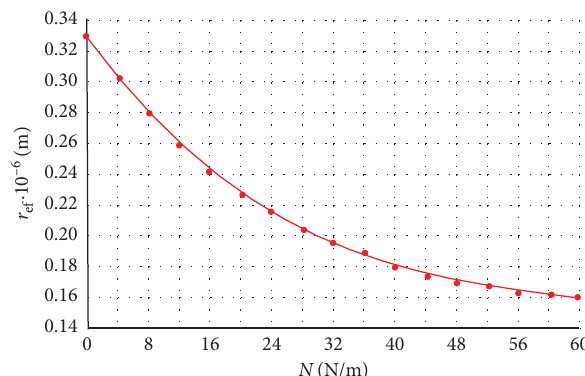
Figure 7: Dependence of the calculated value of r filler on the tensile force N at an impregnation temperature of T � 50 °